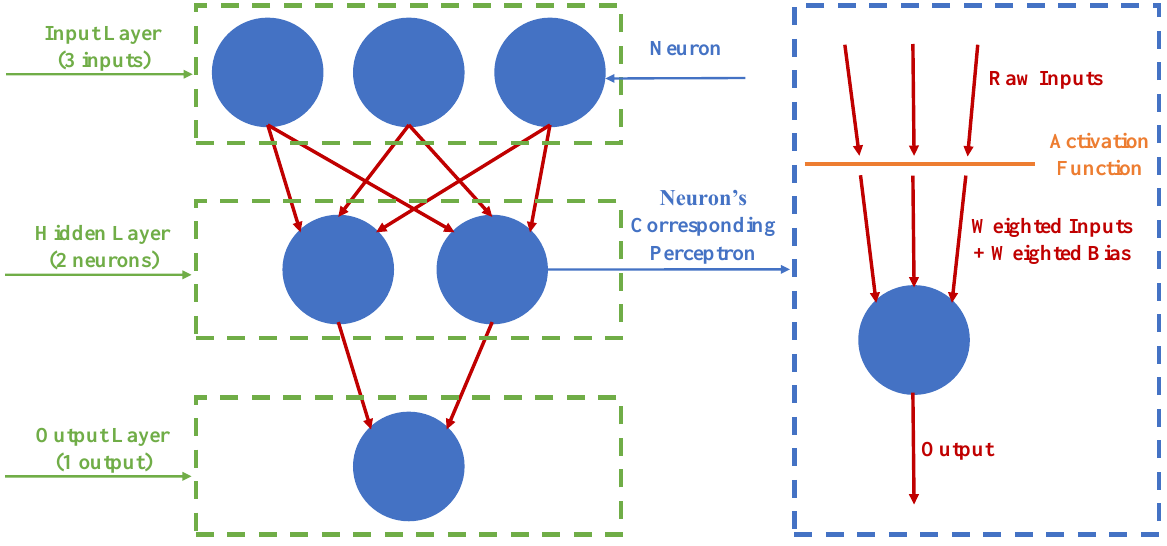
Figure 4. Schematic structure of a simple MLP (Multilayer Perceptron Neural Network). Prior to modeling, training data have to be numerical and scaled. Integer